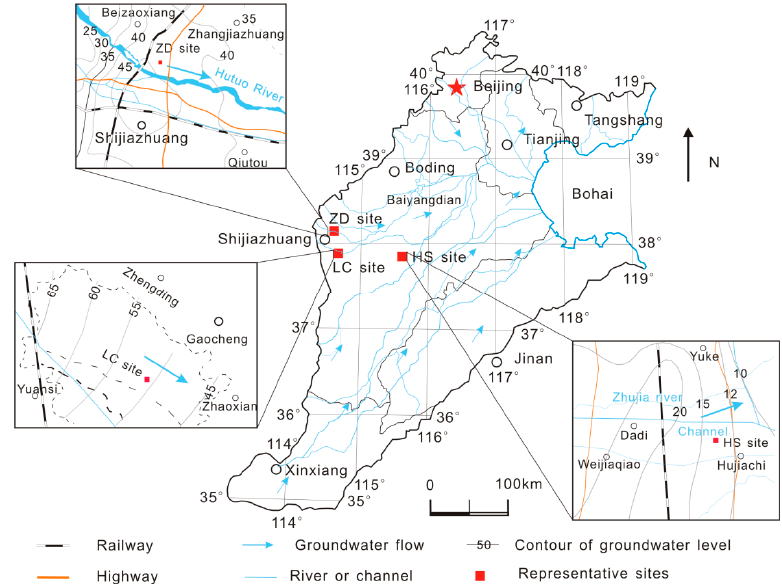
Figure 1. Representative sites of the North China Plain (NCP) in this study: Zhengding (ZD), Luancheng (LC) and Hengshui (HS). Table 1. General features of the ZD, LC and HS sites.